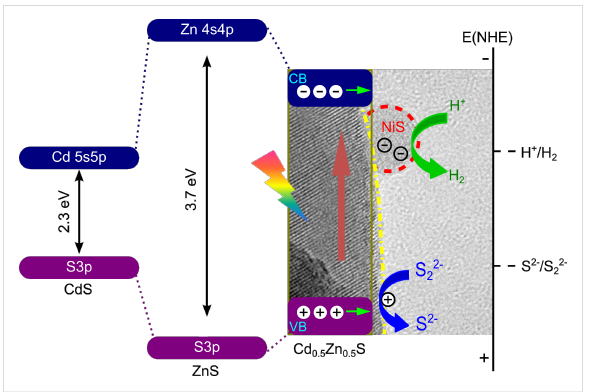
Figure 4: Proposed photocatalytic charge separation process over the band-structure controlled NiS/Cd 0.5 Zn 0.5 S photocatalyst. Reprinted from with permission from [29]. Copyright (2010)